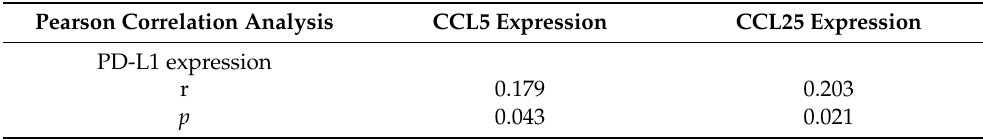
Table 3. Correlations between CCL5/CCL25 and PD-L1 expression.